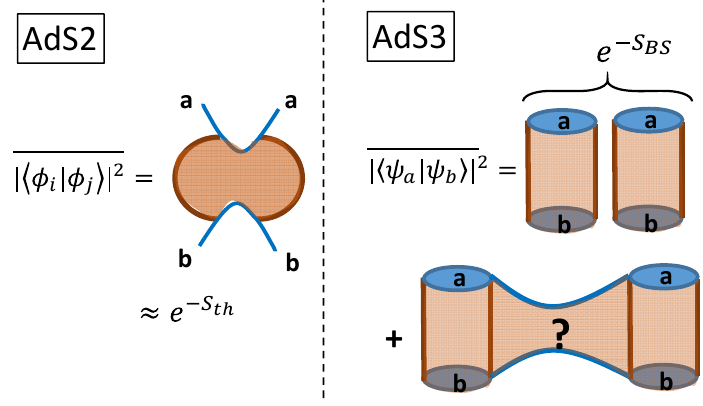
Figure 4 . Gravity evaluations of the averages of squares of inner products in AdS 2 gravity (left) and AdS 3 gravity